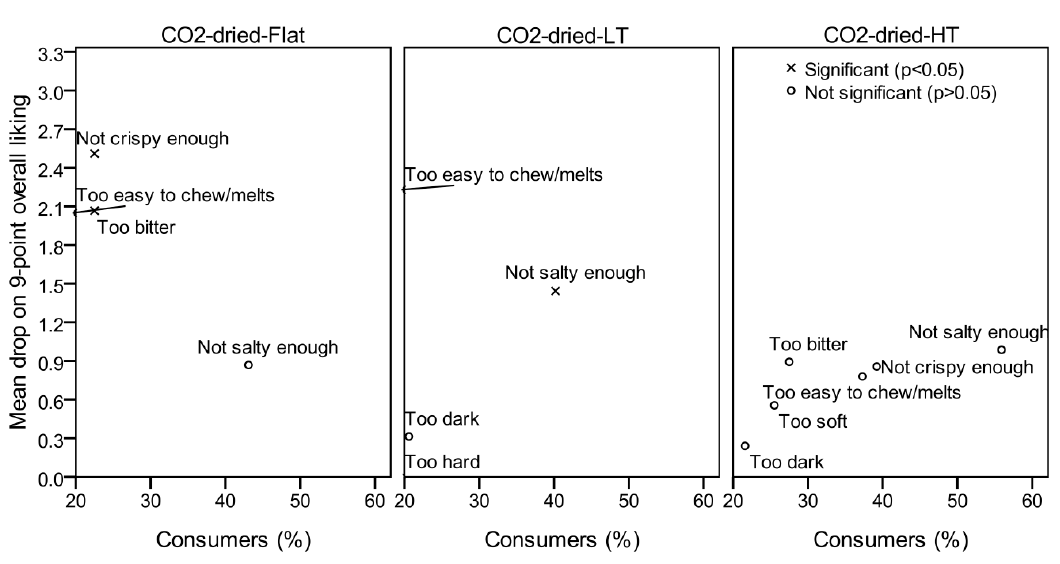
Figure 3. Mean drop analysis for supercritical CO 2 -dried beetroot samples (N = 102 respondents).